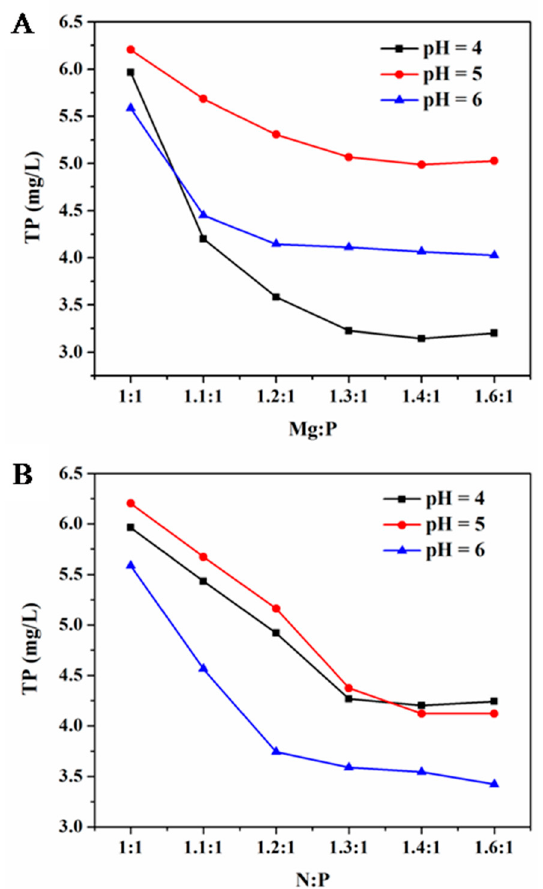
Figure 1. E ff ect of changing Mg:P ( A ) and N:P ( B ) on TP removal under di ff erent pH conditions. Figure 1. Effect of changing Mg:P ( A ) and N:P ( B ) on TP removal under different pH conditions.